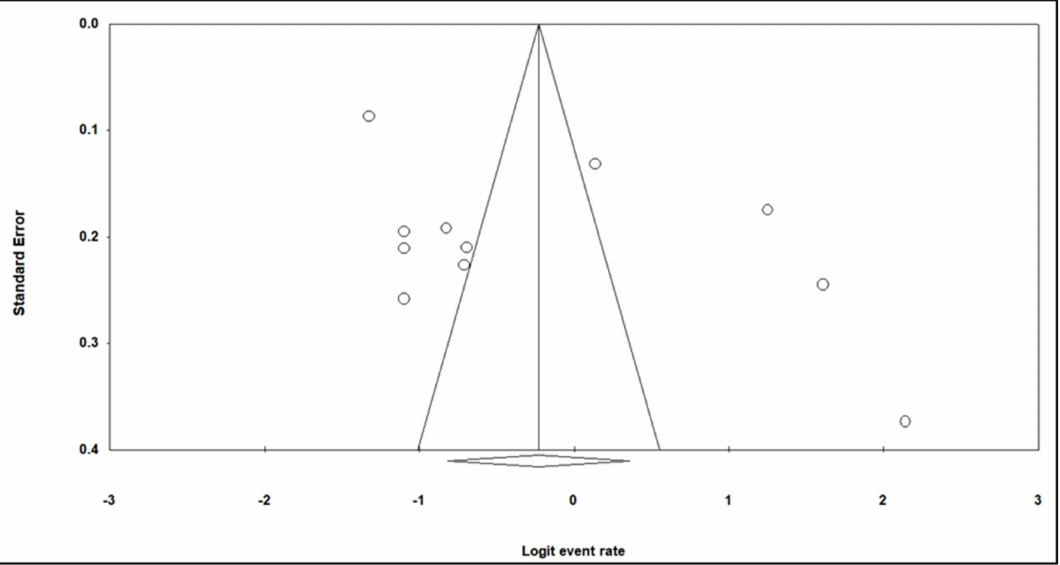
Figure 4. Funnel plot of standard error by logit event rate of this study. The unfilled dots represent the studies